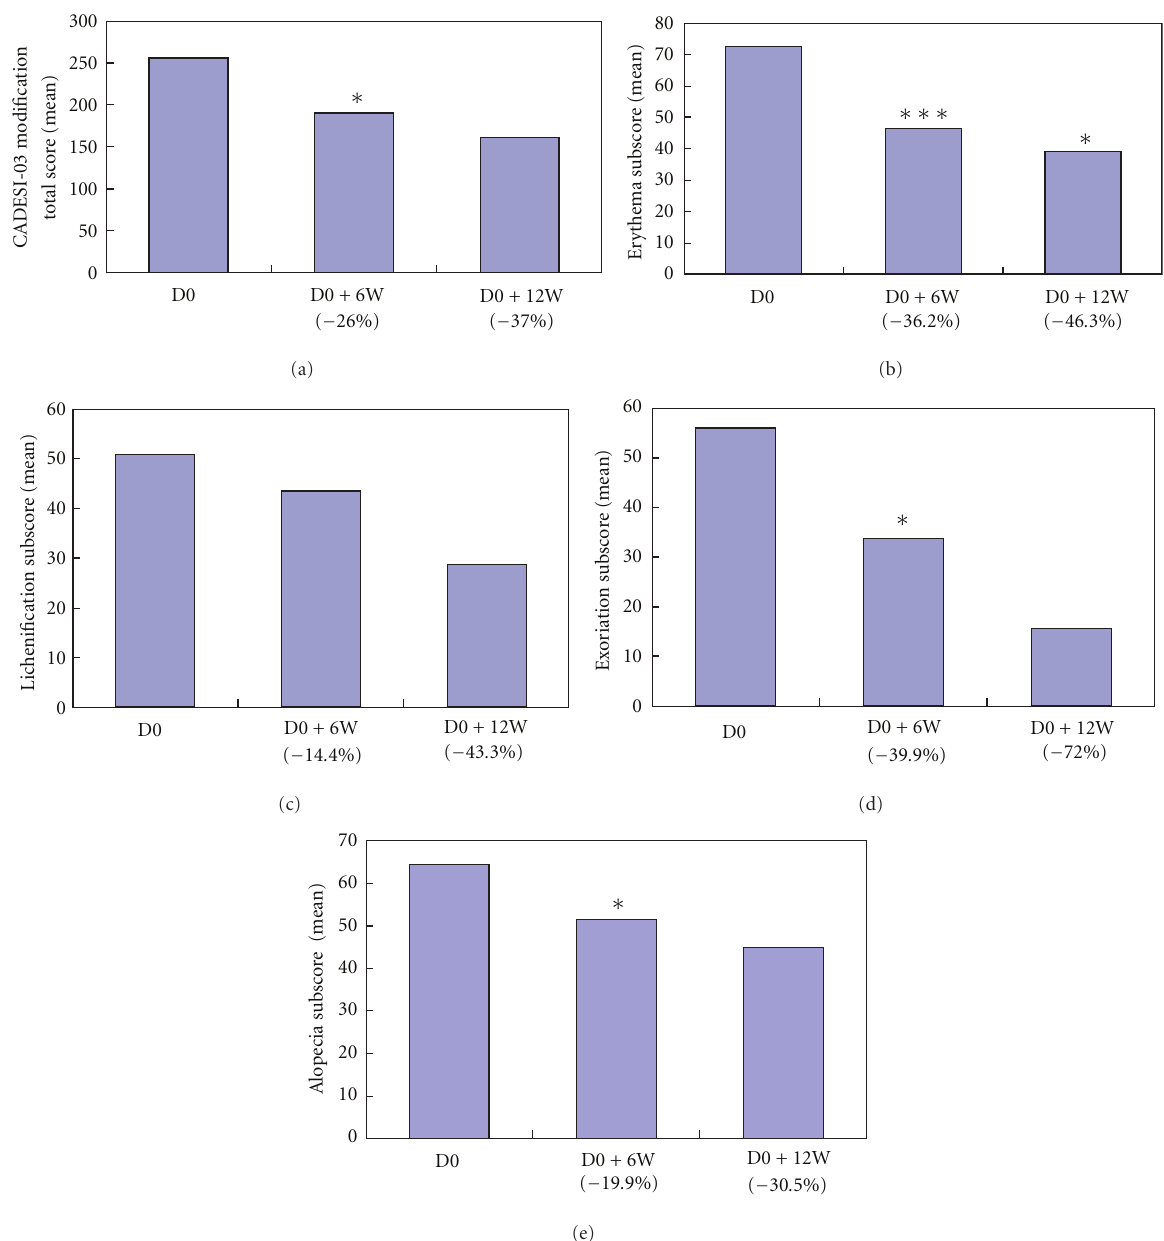
Figure 1: (a) CADESI-03 modification total score improved 6 weeks (D0 + 6W) and 12 weeks (D0 + 12W) after starting treatment (D0) with topical SLC. Results are expressed as mean, n = 7. ∗ P < 0 . 05, compared with D0 score. Number below the abscissa axis indicates average di ff erence rate (%) from D0. (b) Erythema improved dramatically during the trial period. Results are expressed as mean, n = 7. ∗ P < 0 . 05, ∗∗∗ P < 0 . 005, compared with D0 score. Number below the abscissa axis indicates average di ff erence rate (%) from D0. (c) Mean lichenification subscore. Results are expressed as mean, n = 7. Number below the abscissa axis indicates average di ff erence rate (%) from D0. (d) Excoriation improved during the trial period. Results are expressed as mean, n = 7. ∗ P < 0 . 05, compared with D0 score. Number below the abscissa axis indicates average di ff erence rate (%) from D0. (e) Alopecia improved during the trial period. Results are expressed as mean, n = 7. ∗ P < 0 . 05, compared with D0 score. Number below the abscissa axis indicates average di ff erence rate (%) from